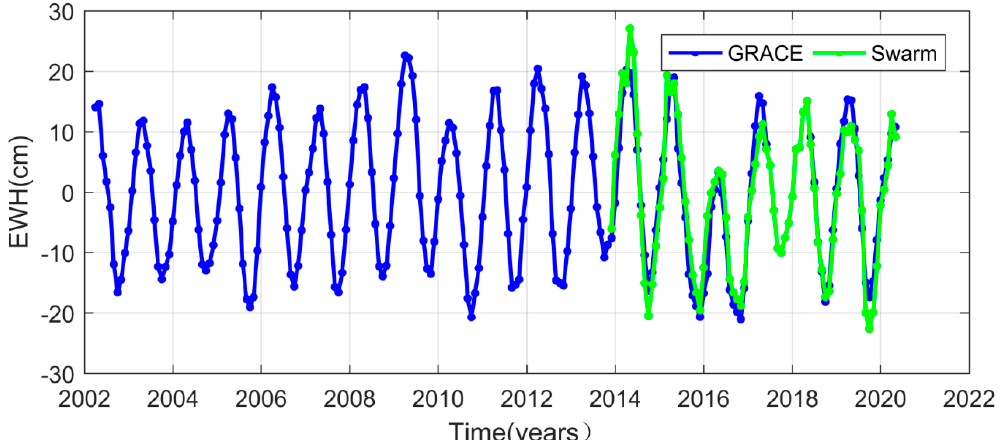
Figure 8. The terrestrial water storage change (TWSC) time series in the Amazon River basin calculated using GRACE (blue curve) and Swarm (green curve). Table 2. Long-term trends and seasonal changes from Swarm and GRACE TVG field. AA and AP present the annual amplitude and annual phase, respectively.